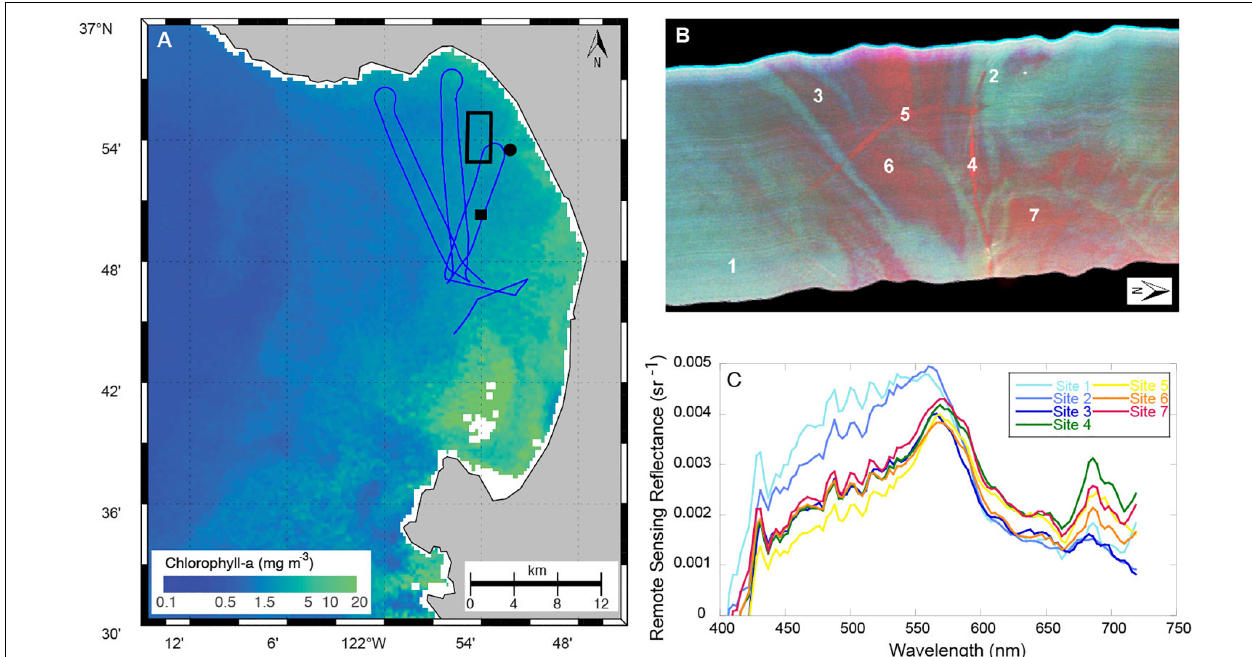
FIGURE 2 | Monterey Bay, CA was the primary target for the airborne missions. (A) The MERIS chl a image from 28 October 2011 (COAST), with the LSA AATS-14 lines (blue) and the “red tide” (CST17; solid circle) and M0 (CST18; solid square) stations. The rectangular box denotes the region depicted in (B) , showing the HIS data as an RGB composite, with red indicating high chlorophyll. (C) The spectra from the labels 1–7 in (B) from the HIS. The water depths for these seven sites range from approximately 18 to 25